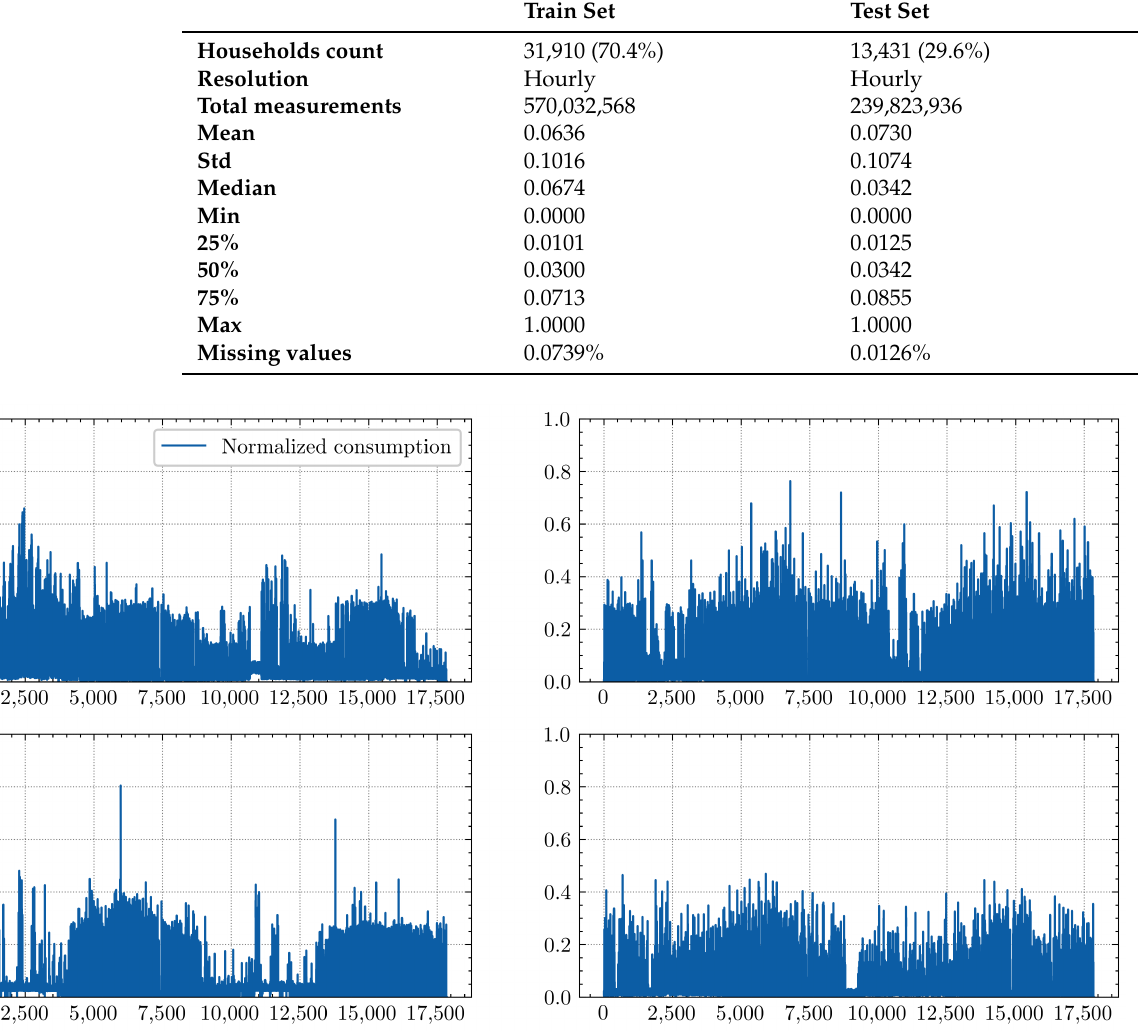
Figure 1. Random samples from SMARKIA SRP